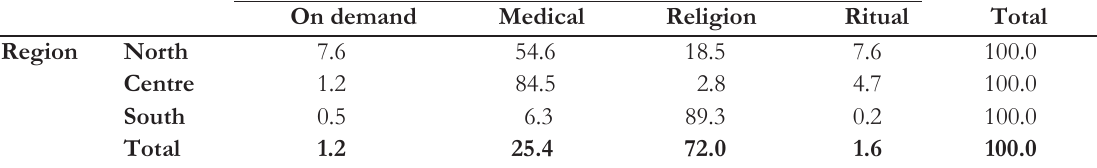
Table 2: Regional distribution of indications for MC (n=1648) in selected district hospitals INDICATIONS On